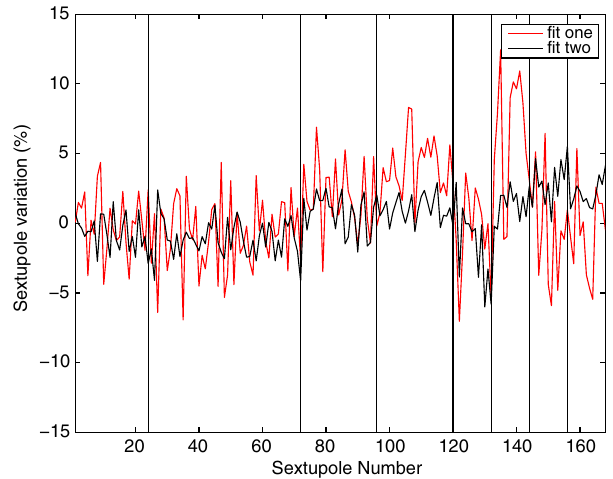
FIG. 9. (Color) Sextupole component variation introduced by the fit in Fig. 7 (red) and in Fig. 8